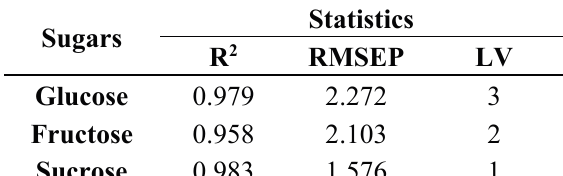
Table 1. Statistic values of Partial Least Square (PLS) discriminant analysis for the quantification of the studied fermentable sugars. (R 2 : coefficient of determination; RMSEP: Root Mean Square Error of Prediction; LV: Latent Variables.)